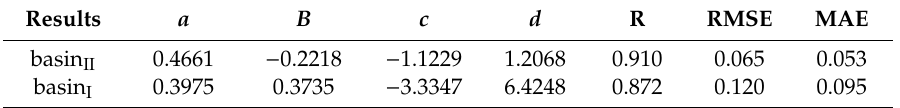
Table 4. Coe ffi cients of a , b, c , d , and the statistical performance criteria to estimate σ * X